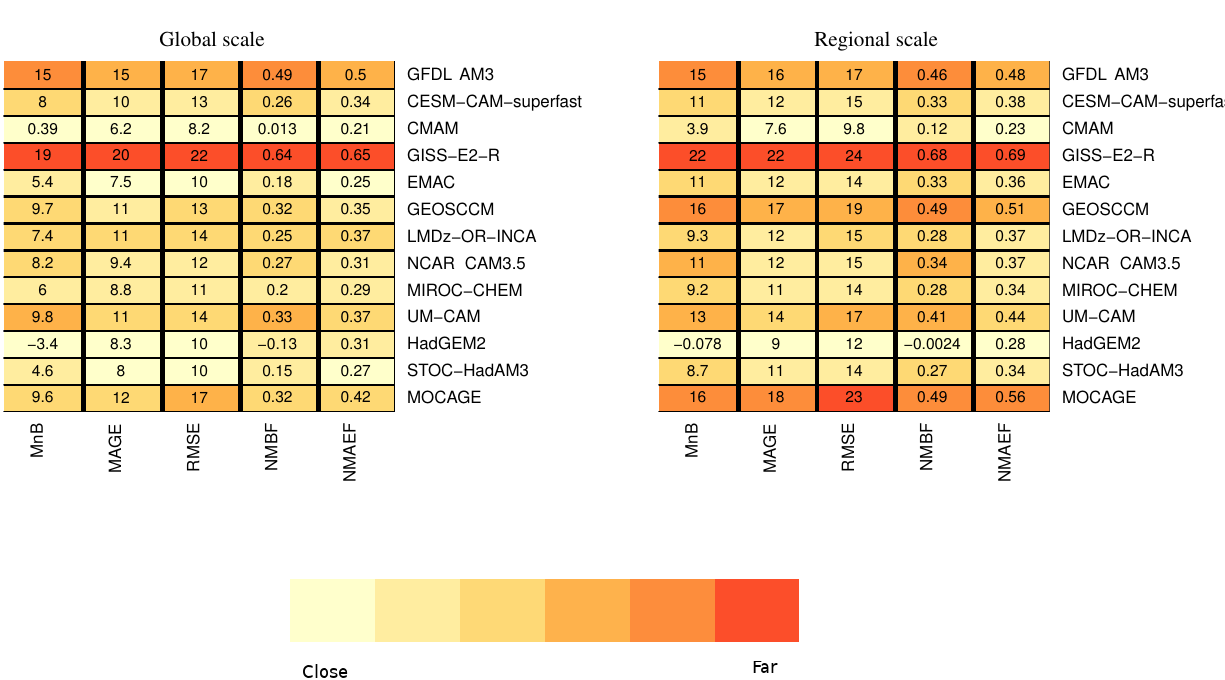
Figure 5. ACCMIP model performances, based on spatio-temporal (annual cycle) comparison of summer surface ozone between observations and ACCMIP models computed over a REF period (1990–2010) from the historical experiment. Rows and columns represent individual models and metrics, respectively. Each cell contains the value of a corresponding metric and a color indicating the performance of the model, from white (close to the observations) to red (far from the observations). The metrics used are mean bias (MnB), mean absolute gross error (MAGE), root mean square error (RMSE), the normalized mean bias factor (NMBF) and the normalized mean absolute error factor (NMAEF). Each metric is calculated at global (left) and regional scales (right). The colors associated with each metric value were determined as follows: the values of each metric have been rescaled between 0 and 1 corresponding to the model that is close to and far from the observations, respectively. The interval [0;1] has been subdivided into 6 equal intervals, each representing a different color. The value of each metric is given by the color of the interval to which the rescaled value belongs.